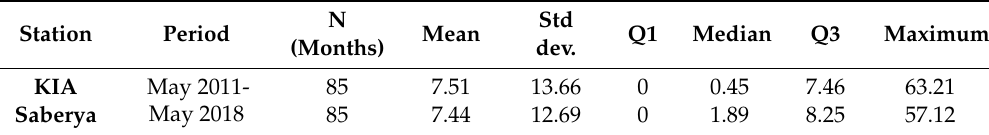
Table 2. A comparison between monthly precipitation records at Kuwait international airport (KIA) and Saberya meteorological stations. Units are in millimeters.